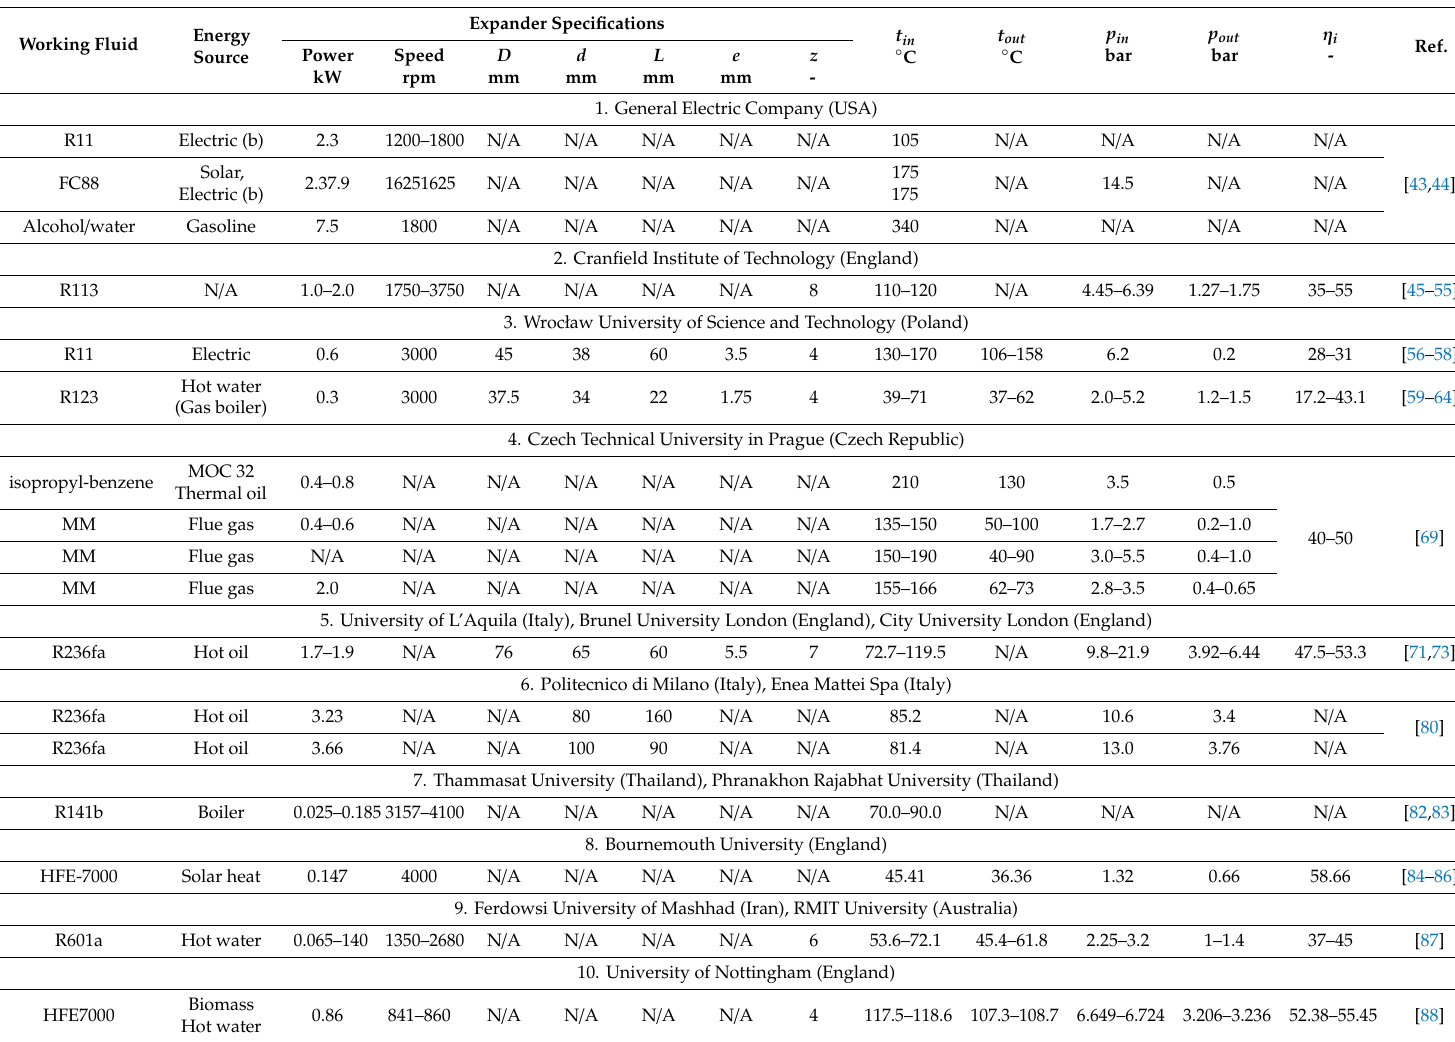
Table 2. Comparison of the results of the experiments that were performed on ORCs with integrated multi-vane expanders in di ff erent scientific units. Working